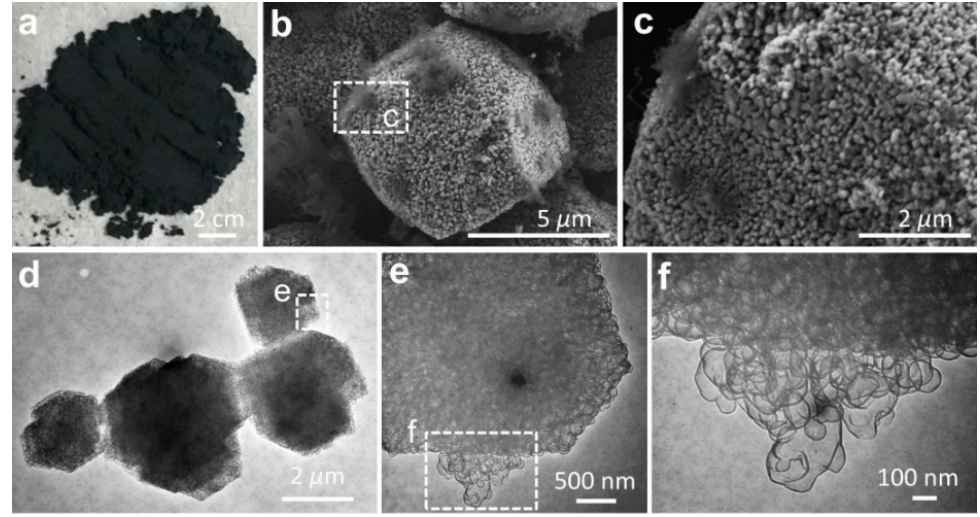
Figure 2. Structural features of G@MgO. ( a ) Digital photo of G@MgO powder. ( b , c ) SEM micrographs of individual G@MgO particles showing epitaxial growth of graphene at MgO. ( d − f ) TEM images of G@MgO resolving the intimate interfacial bonding between the graphene sheets and host MgO laminates.